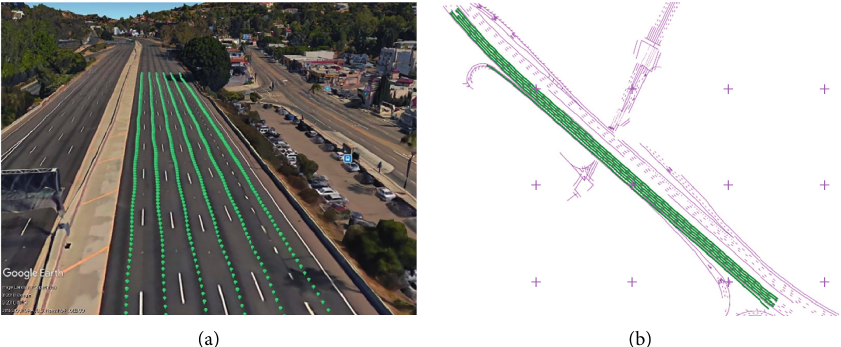
Figure 12: Extraction of the lane’s centerline: (a) extraction results obtained by Google Earth; (b) shapefile of the US101